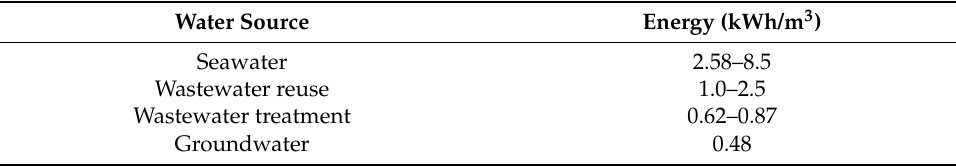
Table 1. Energy requirements for different water